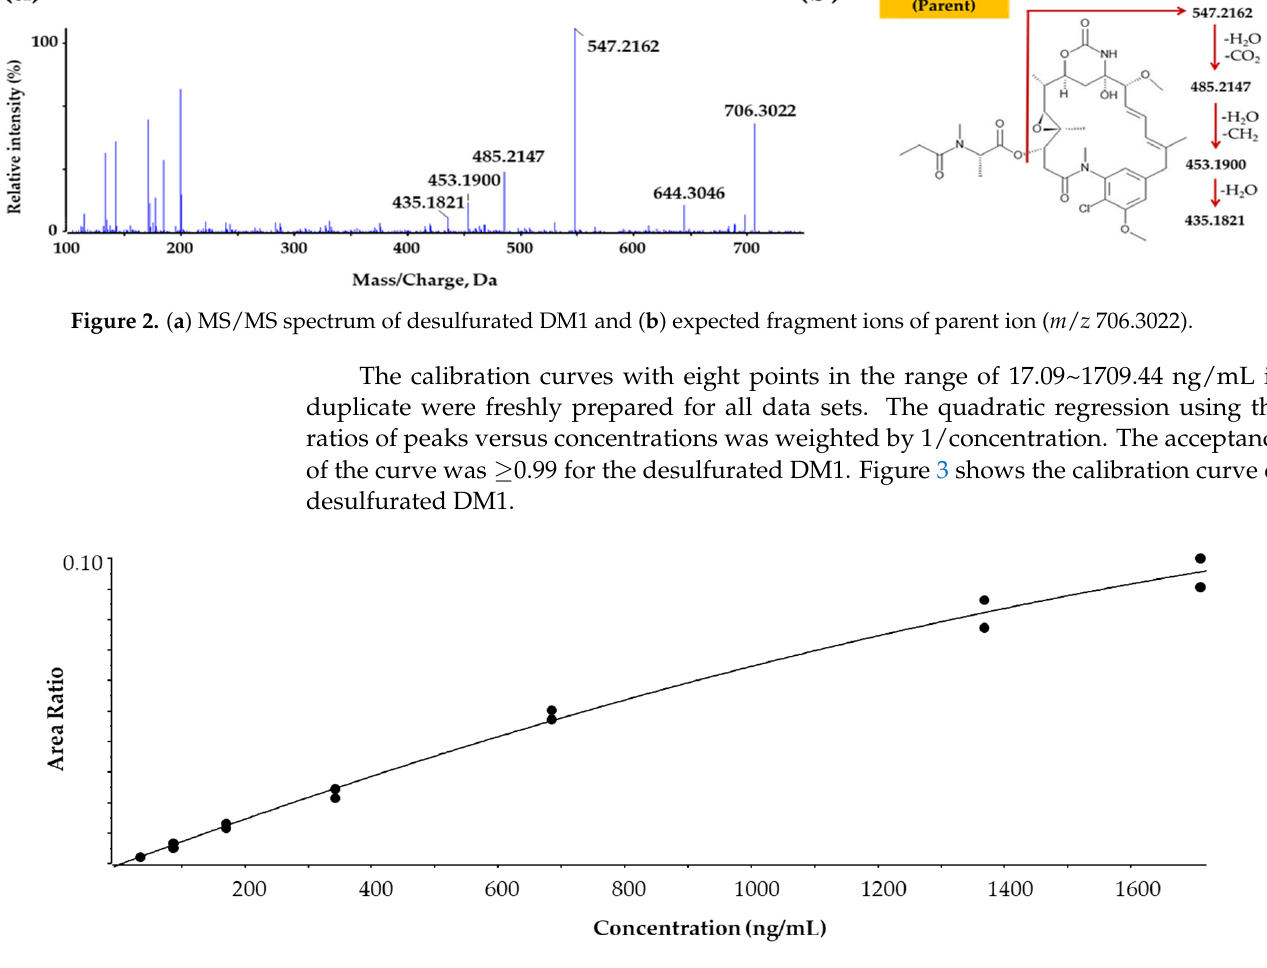
Figure 3. Calibration curve for quantification of desulfurated DM1 (r = 0.99746). Representative chromatograms of the limit of quantification (LLOQ) and high QC are also shown in Figure 4. The peak retention time was the same in all samples. The intra- and inter-day runs for the accuracy and precision assays were performed for method qualification and the results are shown in Table 2. The qualification run met the acceptance criteria of ± 25% accuracy and precision for QC